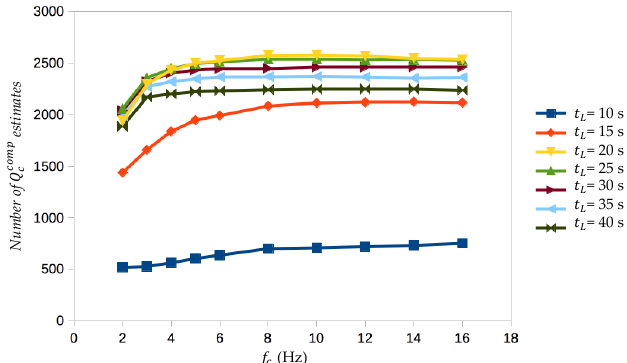
Figure 4. Number of Q comp c estimates, versus the central frequencies f c , for each lapse time t L .